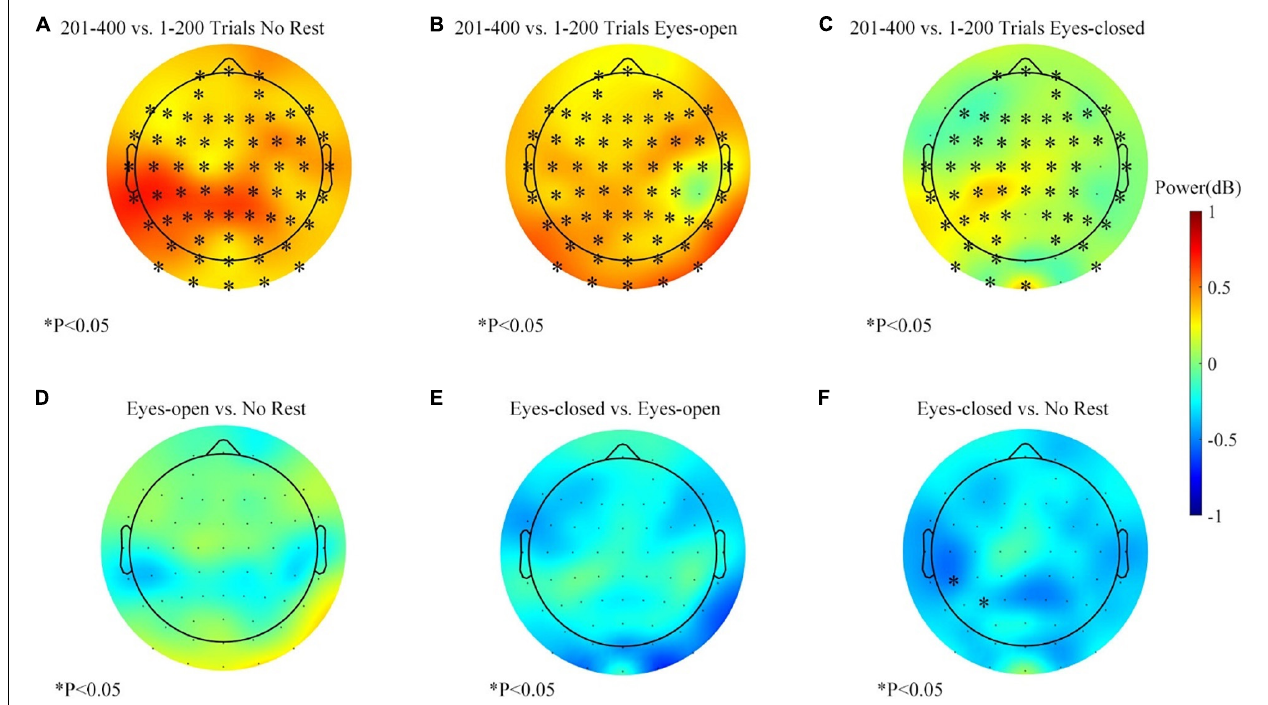
FIGURE 8 | The alpha-band (8–13 Hz) power changes (201–400 vs. 1–200 trials, feedback period) in three sessions for the right target task. (A) Alpha power changes during the no-rest session. (B) Alpha power changes during the eyes-open rest session. (C) Alpha power changes during the eyes-closed rest session. (D) Differences of band power change between the eyes-open session and the no-rest session. (E) Differences of band power change between the eyes-closed session and the eyes-open session. (F) Differences of band power change between the eyes-closed session and the no-rest session. ∗ p ≤